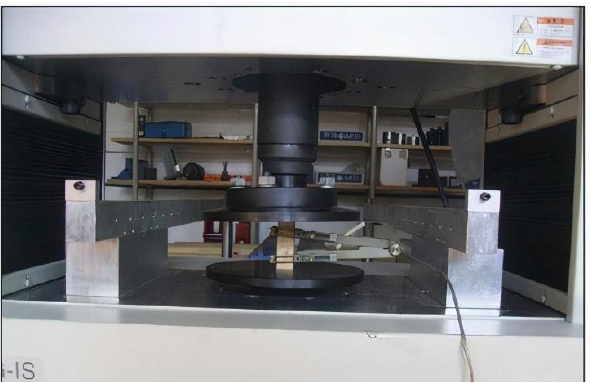
Figure 2. Compression test setup.